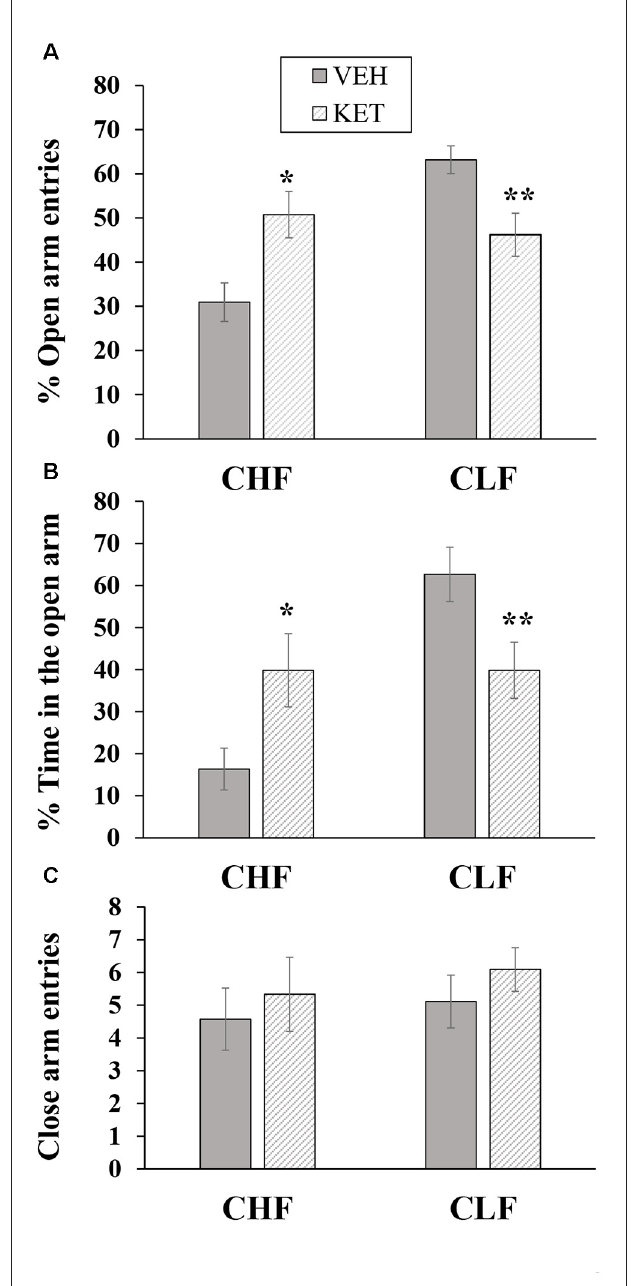
FIGURE 3 | Mean + SEM percentage of open arm entries (A) , percent time spent on the open arms (B) and closed arm entries (C) in the EPM in CHF and CLF animals that received ketanserin (KET) or vehicle (VEH) microinjections in the IL cortex. ∗ p < 0.05 KET vs. VEH among CHF animals; ∗∗ p < 0.05 KET vs. VEH among CLF